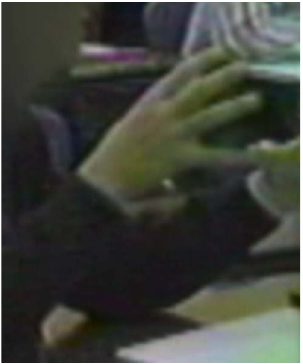
FIG. 6. (cid:1) Color (cid:2) Shape-indicating gesture. “ (cid:3) G-S (cid:4) Imagine a ball floating in space … .”